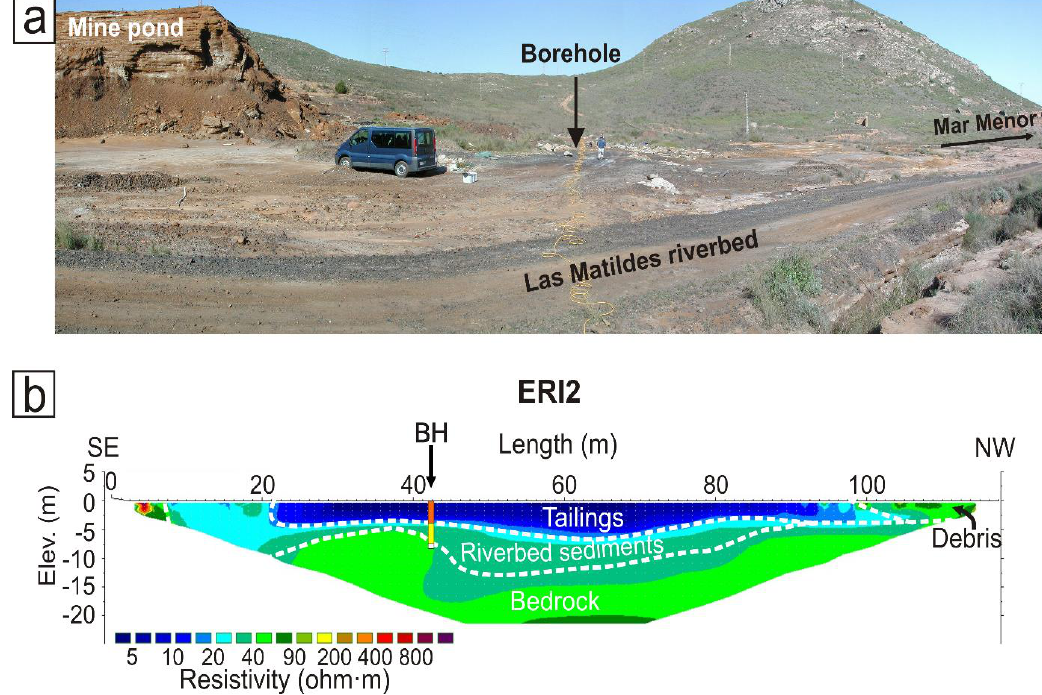
Figure 4. Las Matildes riverbed: ( a ) general view with borehole location; ( b ) ERI profile showing the three identified units; BH: borehole.